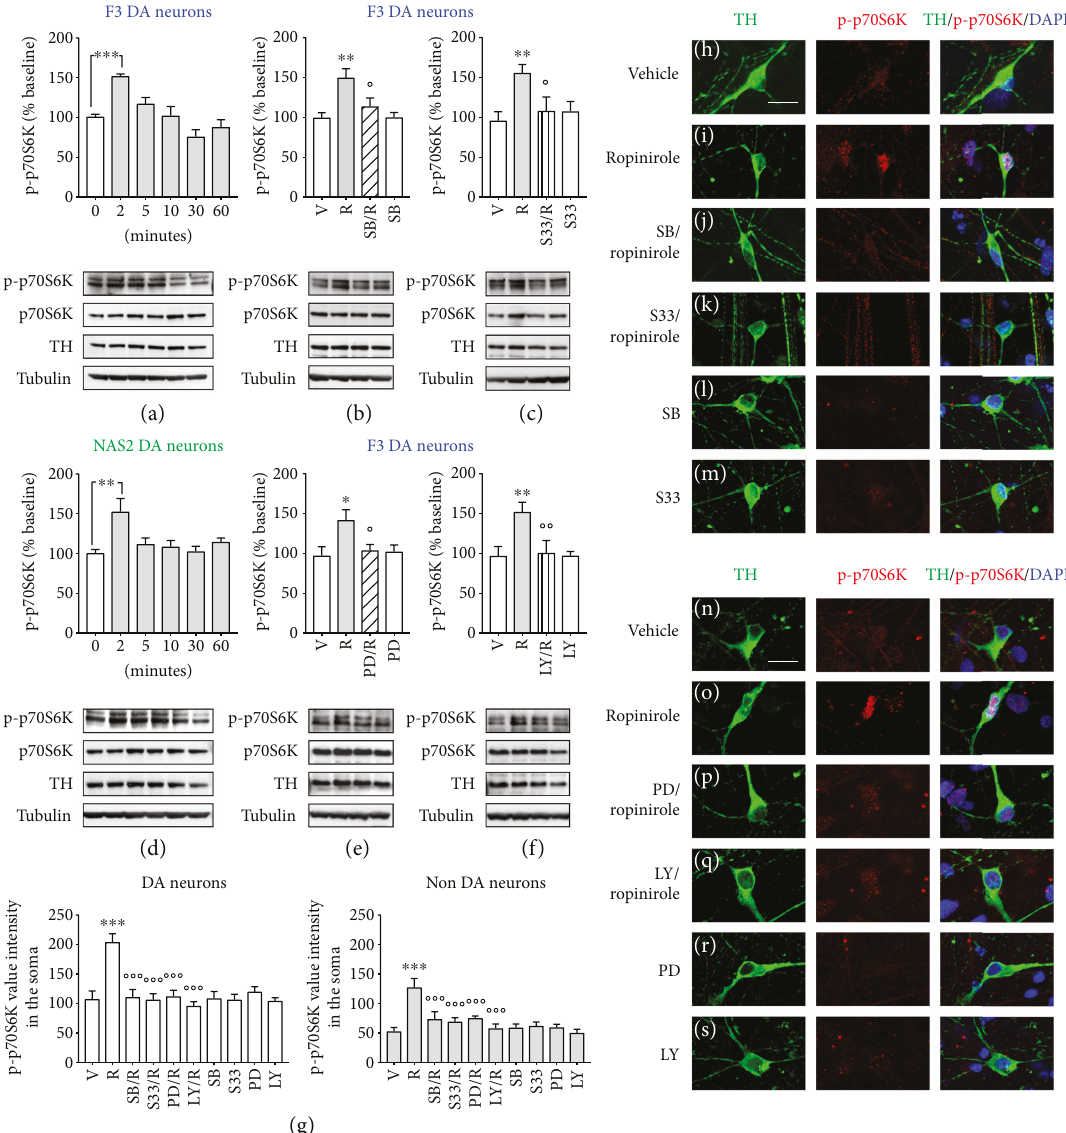
Figure 3: Ropinirole increases phosphorylation of p70S6K in human iPSC-derived DA neurons via activation of D3 receptor. (a, d) Time course of phosphorylated p70S6K (p-p70S6K) induced by ropinirole (10 μ M) in (a) F3 and (d) NAS2 DA cultures, respectively, at 0, 2, 5, 10, 30, and 60 min and analysed by densitometry of Western blots ( n = 6 ) (top panels); the speci fi c levels of p-p70S6K were normalised to the corresponding p70S6K, TH, and tubulin levels. The densitometric values are represented as the percentage of vehicle values. (lower panels) Representative Western blots. (b, c) Blockade of p-p70S6K induced by ropinirole (10 μ M) in F3 DA neurons after pretreatment (20 min) with the D3R antagonists (b) SB277011-A (100nM) or (c) S33084 (10nM) assessed after 2min and analyzed by densitometry of Western blots ( n = 3 ) (top panels). (lower panels) Representative Western blots. (h – m) Representative photomicrographs of F3 DA neurons showing p-p70S6K increase in the soma and dendrites of TH + neurons 2min after ropinirole (10 μ M) following pretreatment with vehicle (i). (j) Blockade of p-p70S6K by pretreatment (20 min) with either SB277011-A (100nM) or (k) S33084 (10 nM) followed by ropinirole (2 min). (h) Vehicle; (l) SB277011-A alone; and (m) S33084 alone. TH (green) and p-p70S6K (red). Cell nuclei were stained with DAPI (blue). (e, f) Blockade of p-p70S6K induced by ropinirole (10 μ M) in F3 DA neurons after pretreatment (20 min) with (e) the MEK inhibitor PD98059 (10 μ M) or (f) the PI3-K inhibitor LY294002 (10 μ M) assessed after 2 min and analyzed by densitometry of Western blots ( n = 3 ) (top panels). (lower panels) Representative Western blots. (n – s) Representative photomicrographs of F3 DA neurons showing p-p70S6K increase in the soma and dendrites of TH + neurons 2min after ropinirole (10 μ M) following pretreatment with vehicle (o). (p) Blockade of p-p70S6K by pretreatment (20 min) with PD98059 (10 μ M) or (q) LY294002 (10 μ M) followed by ropinirole (2 min). (n) Vehicle; (r) PD98059 alone; and (s) LY294002 alone. TH (green) and p-p70S6K (red). Cell nuclei were stained with DAPI (blue). Scale bar: 20 μ m. (g) Semiquantitative image analysis of p-p70S6K fl uorescence intensity in TH + and TH − neurons. All data are expressed as mean values ± SEM ( ∗∗∗ p < 0 001 , ∗∗ p < 0 01 , and ∗ p < 0 05 versus vehicle; ooo p < 0 001 , oo p < 0 01 , and o p < 0 05 versus ropinirole; post hoc Bonferroni ’ s test). V, vehicle; R, ropinirole; SB, SB277011-A; S33, S33084; PD, PD98059; LY,